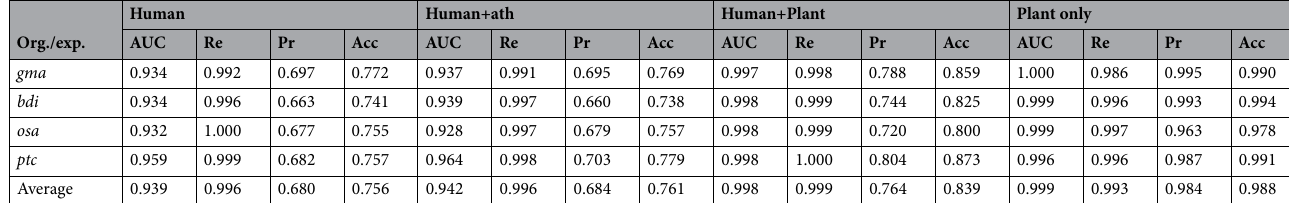
Table 3. Performance of the four (Human, Human+ath, Human+Plant, and Plant) classifiers in each of the four test plant species ( Glycine max , Oryza sativa , Populus trichocarpa , and Brachypodium distachyon ).